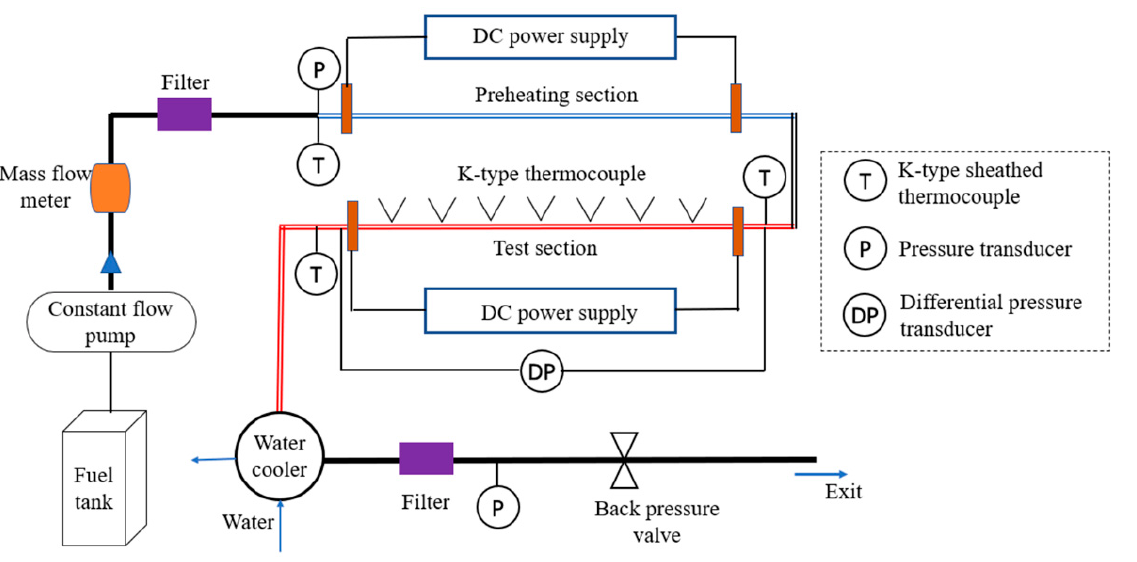
Figure 1. Experimental device used for fuel deposition test.